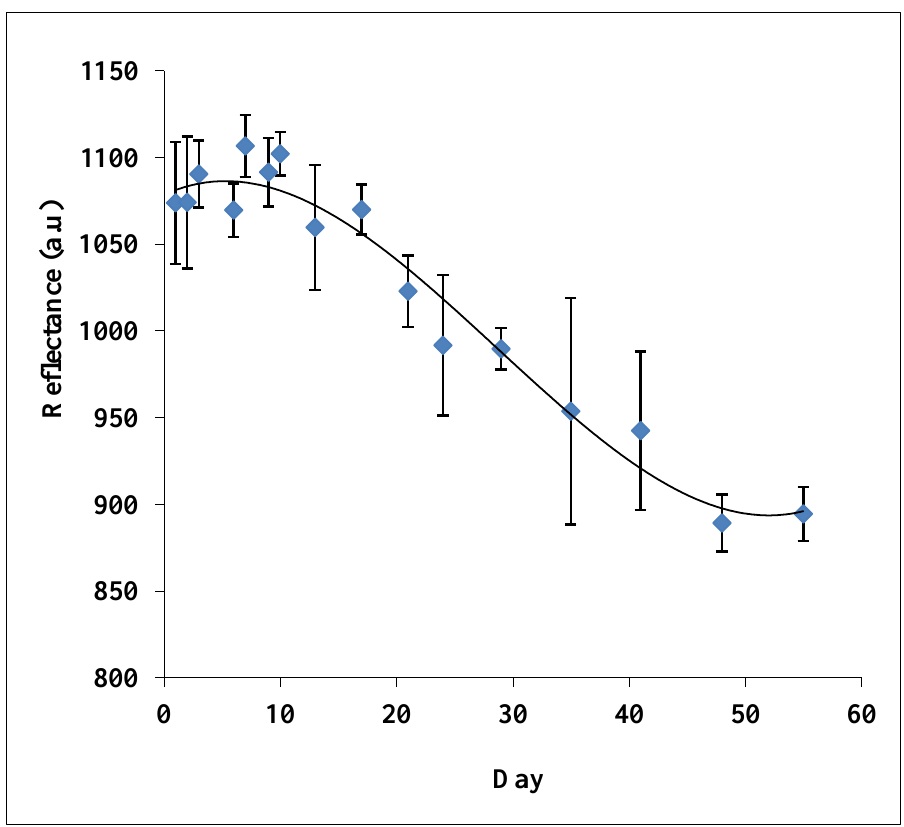
Figure 12. The optical urea biosensor response over 55 days experimental period using 600 mM urea in 50 mM phosphate buffer (pH 7) ( n =